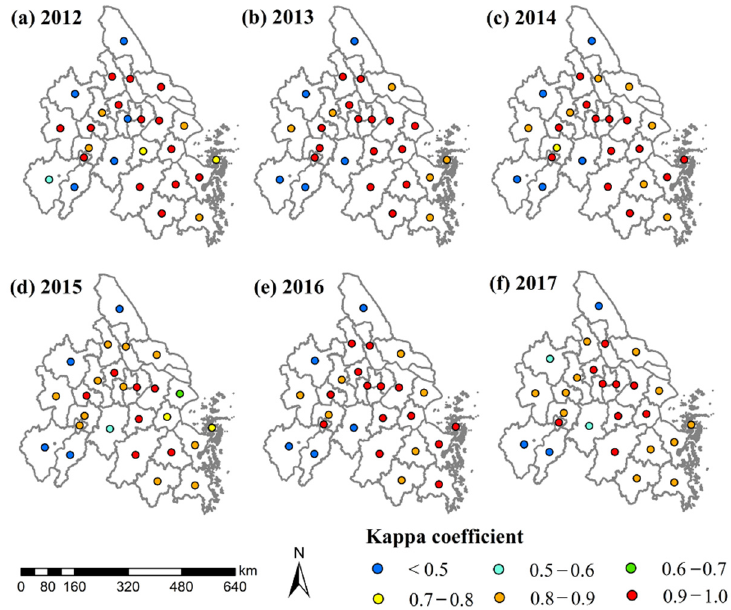
Figure 3. Kappa coefficient for urban area extraction in the YRD.